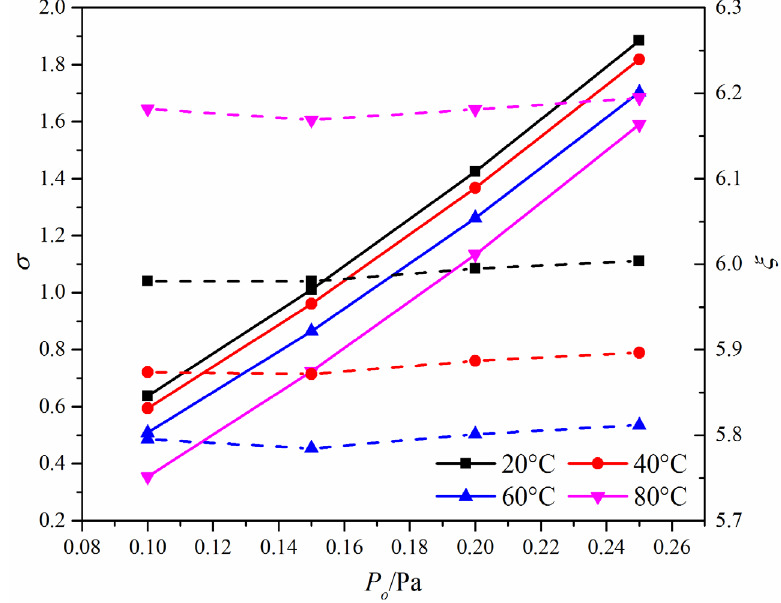
Figure 9. Cavitation number and loss coefficient of two-cage globe valve with different outlet pressure and working temperature.